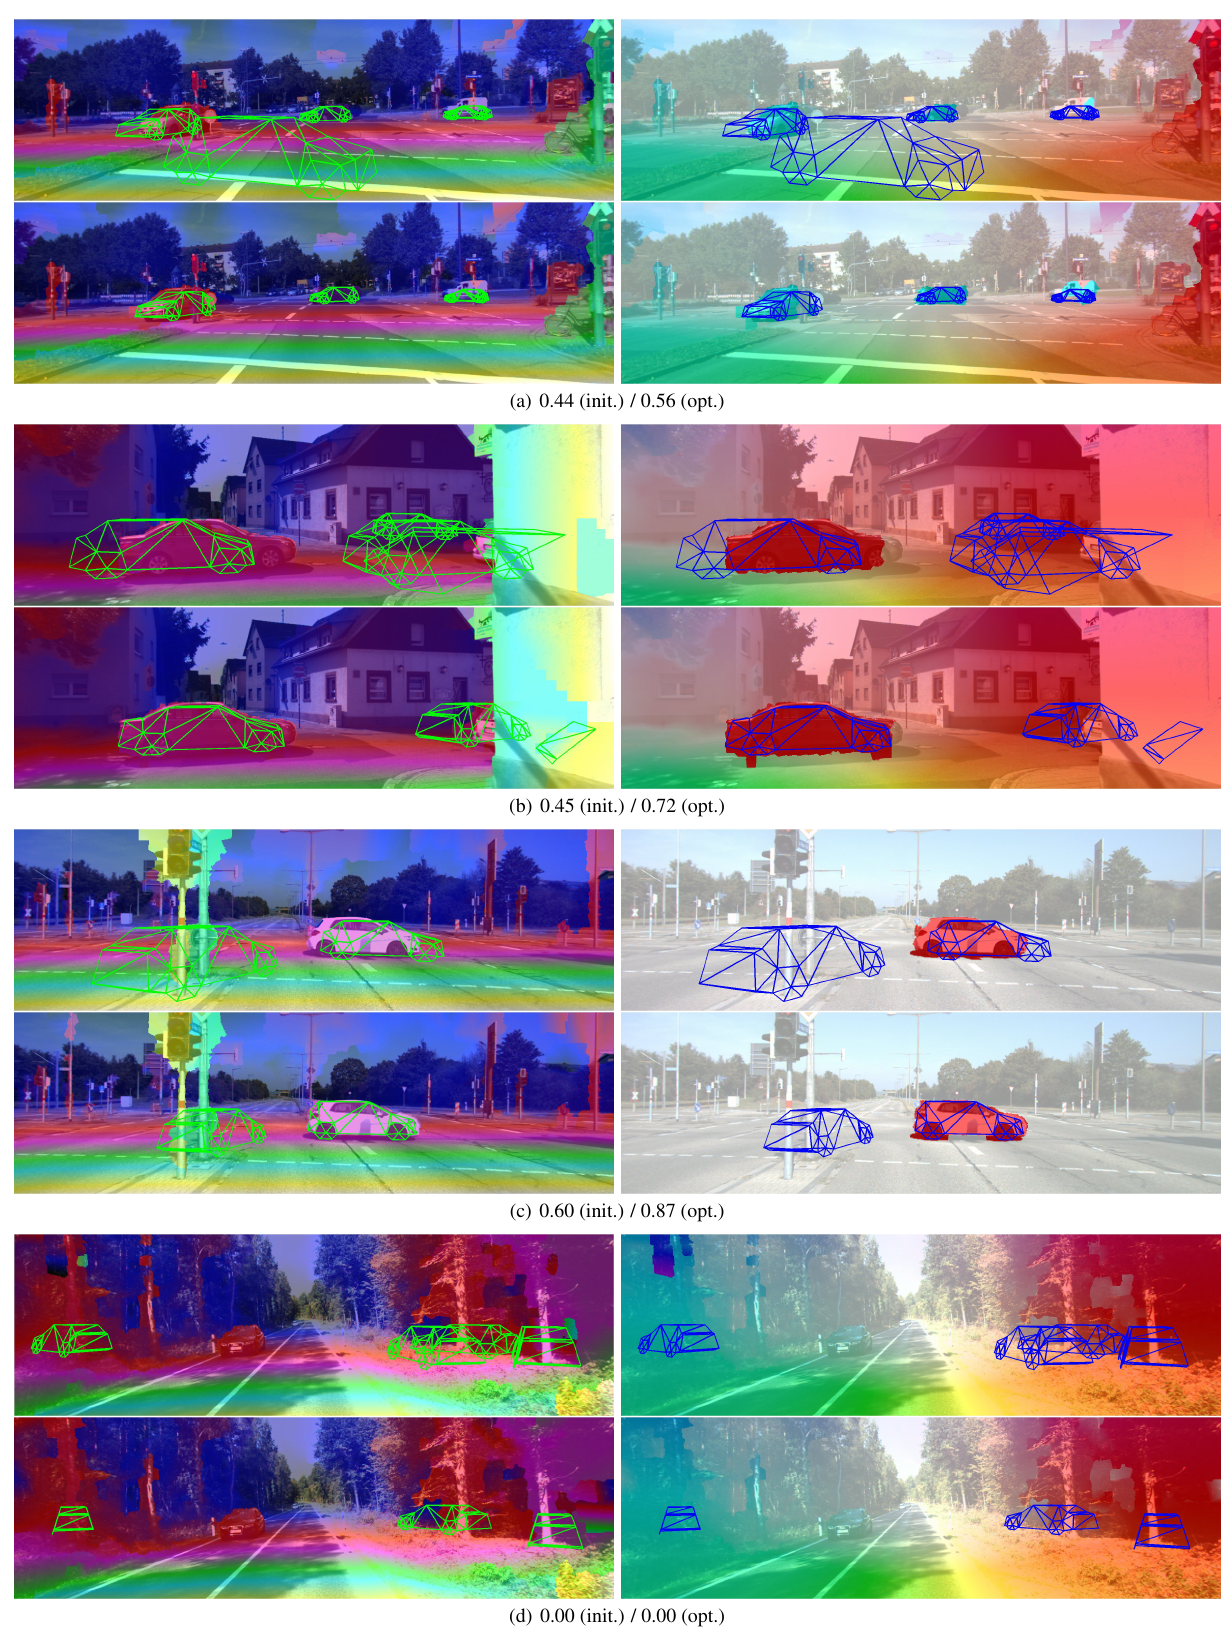
Figure 6. Qualitative Results. Each sub-figure shows our results at initialization (top) and after optimization (bottom). The reference view is superimposed with the color-coded disparity (left) and optical flow map (right). Object models are depicted as green and blue wire-frames. The numbers in the sub-captions specify the value of the intersection-over-union criterion at initialization and after